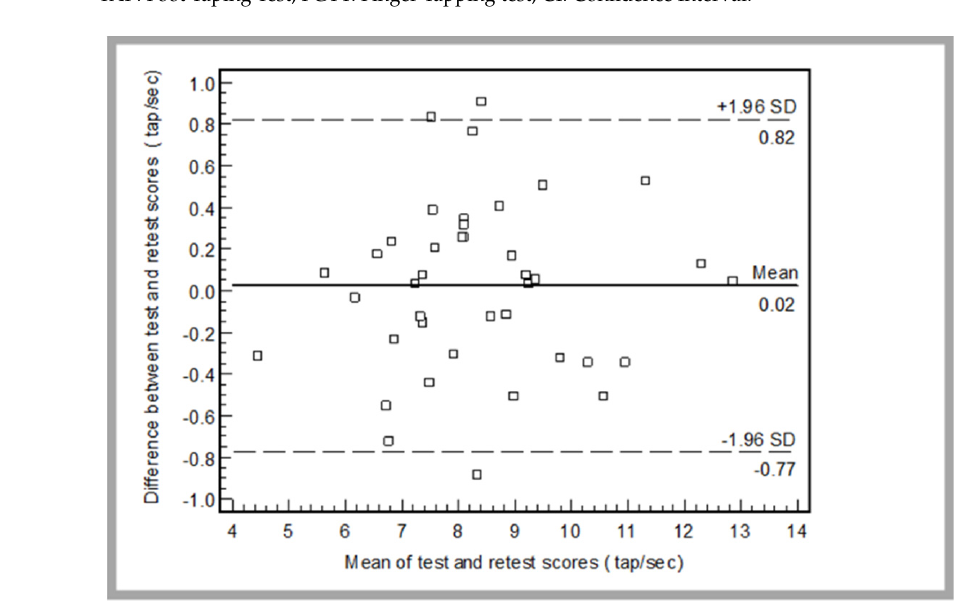
Figure 3. Bland and Altman plots with limit of agreement (dashed line) of test–retest of the TAP. The differences between test–retest scores (TAP score2–TAP score1) plotted against their mean (dot line) for each subject. The residual errors between TAP scores on test and retest were normally distributed